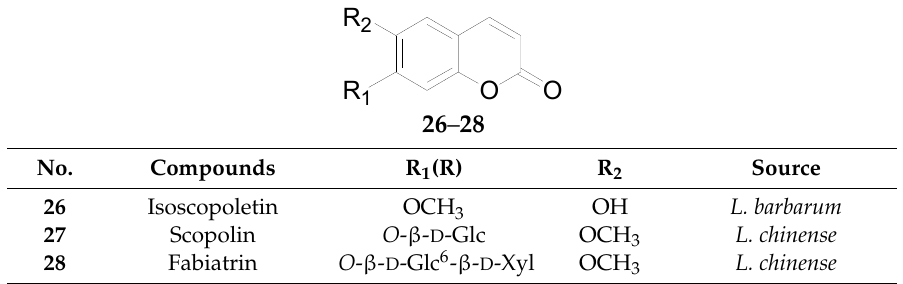
Table 3. Chemical structures of compounds 26 – 28 .